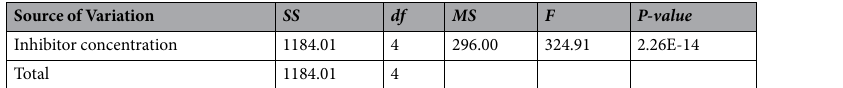
Source of Variation SS